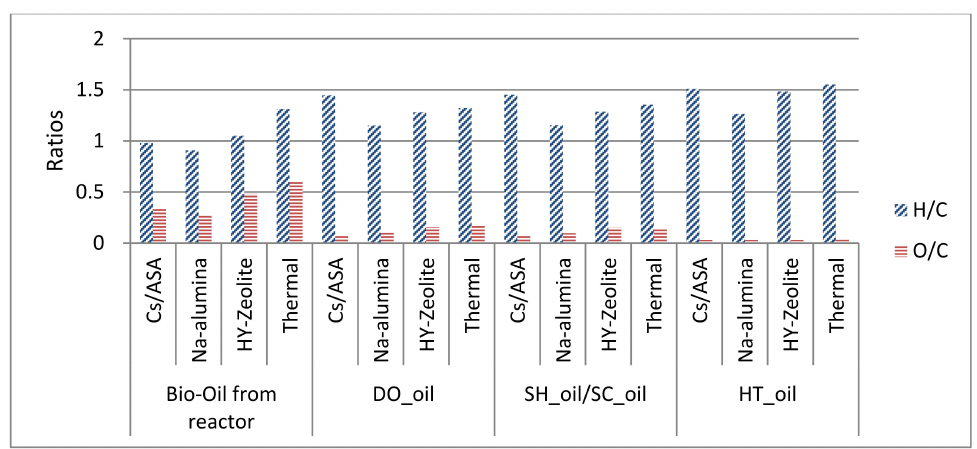
Figure 5. Hydrogen to Carbon (H / C) and Oxygen to Carbon (O / C) ratios for oil at different stages / scenarios in the process.